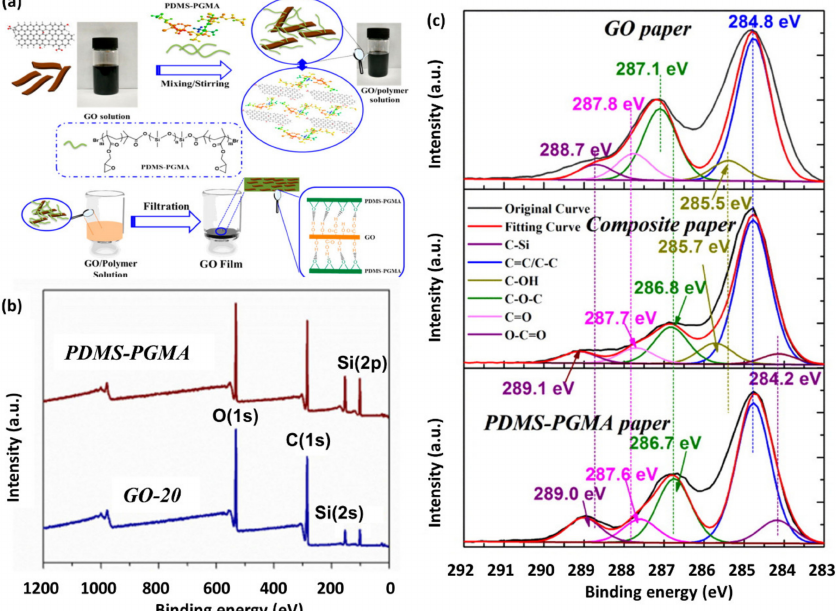
Figure 5. ( a ) Schematic illustration for the preparation of GO / polydimethylsiloxane-poly(glycidyl methacrylate (PDMS − PGMA) composite paper achieved through mixing GO solution with PDMS − PGMAtriblockcopolymer, ( b )surveyspectraofPDMS-PGMAandGO / PDMS-PGMAcomposite papers, and ( c ) deconvoluted C(1s) XPS spectra of GO, PDMS-PGMA, and GO / PDMS-PGMA composite films. (Reproduced with permission from Reference [34]; Copyright (2016) American Chemical